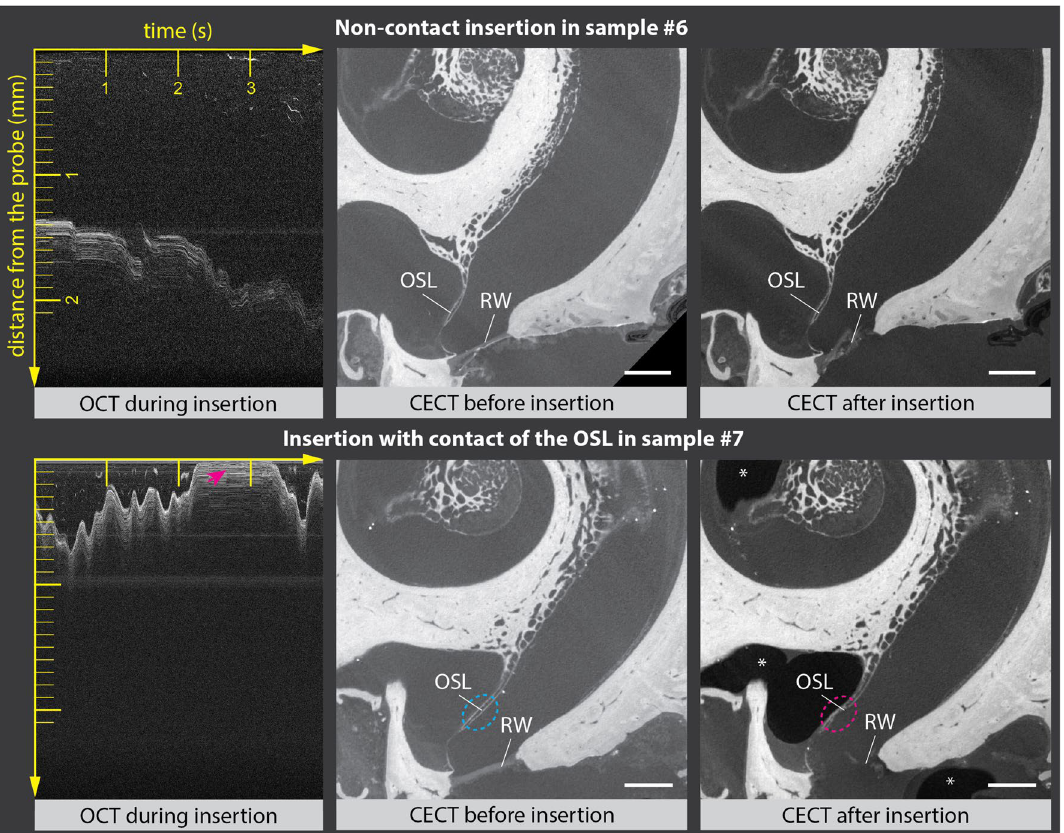
Figure 4. Wall contact during insertion as an indicator of trauma. (top) Experimental data of sample #6: intra- insertion OCT data, showing no contact between the optically-guided sheath and the OSL, together with the pre- and post-insertion CECT images, showing no trauma. (bottom) Experimental data of sample #7: intra- insertion OCT data together with the pre- and post-insertion CECT images. The blue ellipse indicates intact OSL on pre-insertion CECT images. The red arrow shows contact between the optically-guided sheath and the OSL, detectable on real-time OCT images, and the resulting impression microtrauma of the OSL (red ellipse) on CECT images, acquired after the insertion. On the post-insertion CECT image, (*) indicates the presence of intracochlear air, which was not related to the insertion. In both cochleae, the optically-guided sheath was inserted through an incision in the membrane, covering the round window. Horizontal and vertical axis of the OCT images are in correspondence with Fig. 2. OSL , osseous spiral lamina, RW round window. Scale bar: 1 mm.